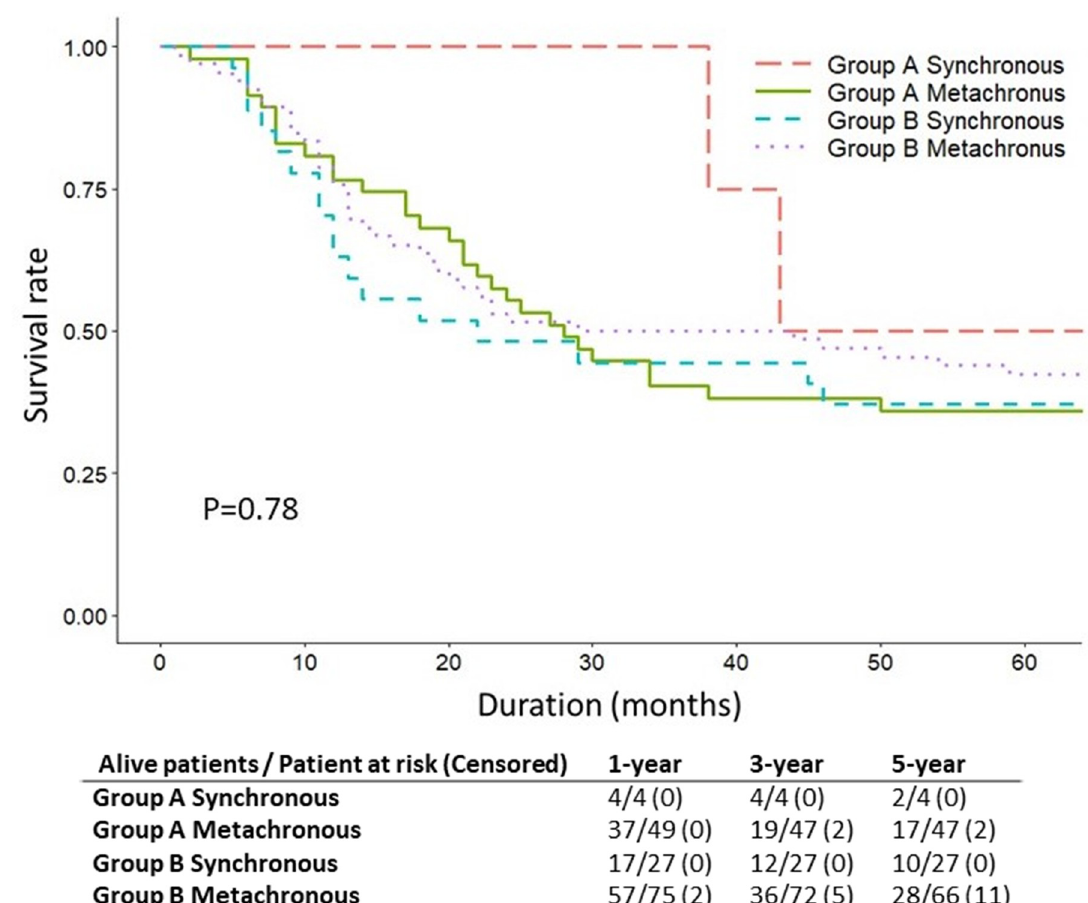
Fig 4. Kaplan-Meier survival curves for synchronous and metachronous second primary malignancy (SPM) in Group A and Group B.